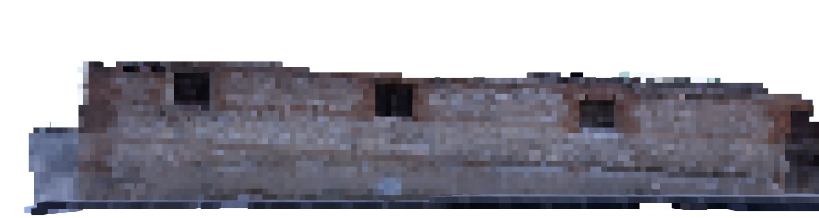
Figure 18. Voxelization with a voxel size of 15 cm.